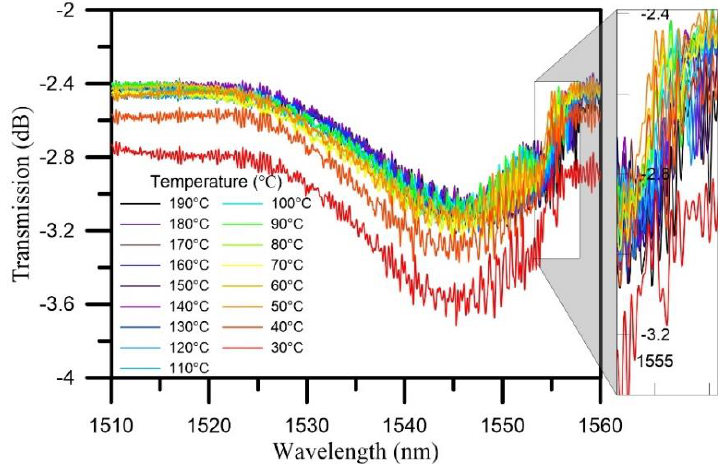
Figure 10. The transmission spectrum of the TFBG sensor during the cooling stage.